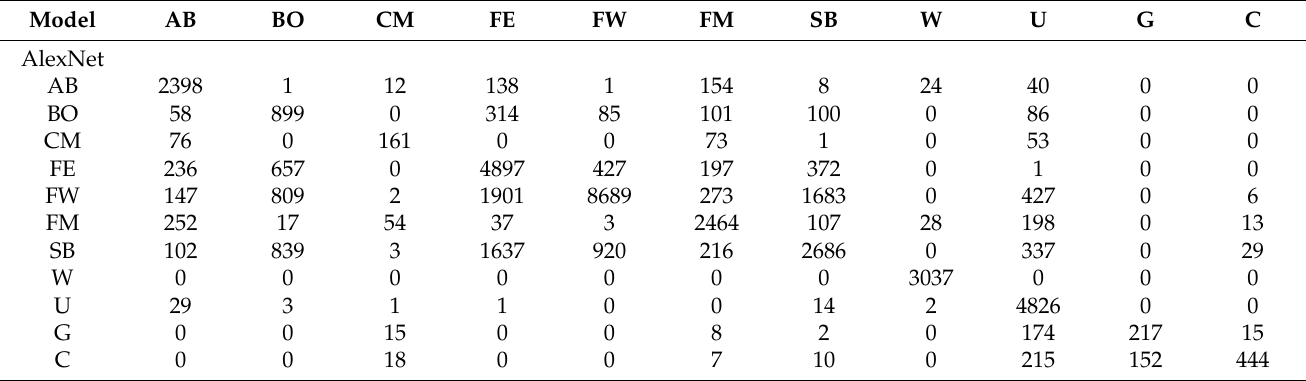
Table 5. Confusion matrix of the AlexNet (AB = Aquatic bed, BO = Bog, CM = Coastal marsh, FE = Fen, FM = Freshwater marsh, FW = Forested wetland, SB = Shrub wetland, W = Water, U = Urban, G = Grass, C = Crop).